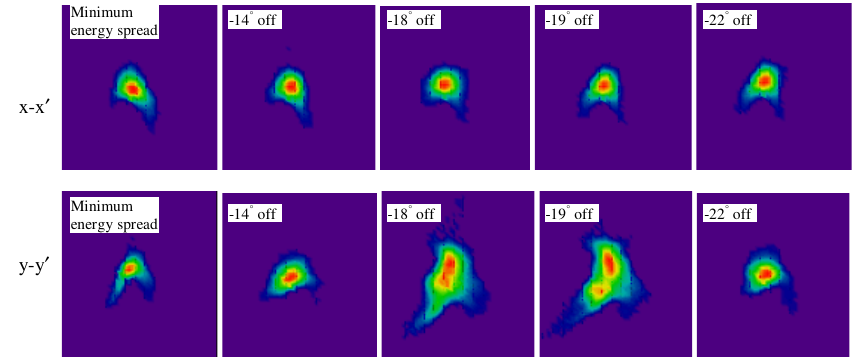
FIG. 3. (Color) Reconstructed transverse phase spaces of 60 MeV beams with minimum energy spread, under, near full, full, and over compression operating at (cid:6) 8 (cid:3) , (cid:6) 14 (cid:3) , (cid:6) 18 (cid:3) , (cid:6) 19 (cid:3) , and (cid:6) 22 (cid:3) rf off-crest phase, respectively; top plots are x - x 0 (nonbending plane), and bottom plots are y - y 0 (bending plane); the abscissa axis is x ( y ), and the ordinate axis is x 0 ( y 0 ). The calibration in all sets is 3 : 2 mm (cid:8) 0 : 71 mrad